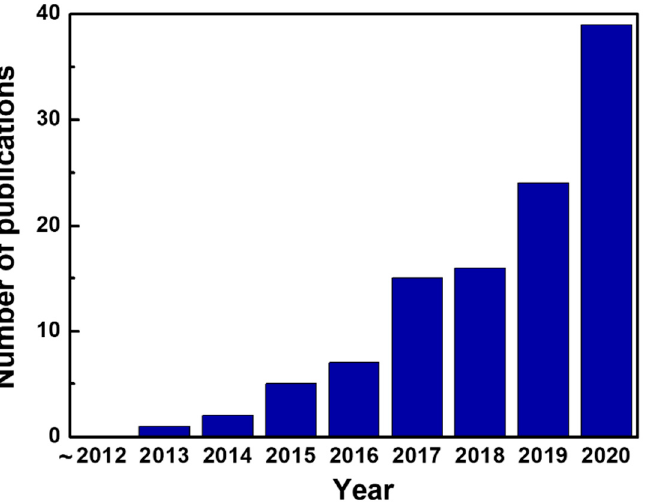
Figure 2. The number of publications reporting the use of Zr-MOFs, Ti-MOFs, Hf-MOFs, or Ce-MOFs for sensors published in each year, obtained from Web of Science database.